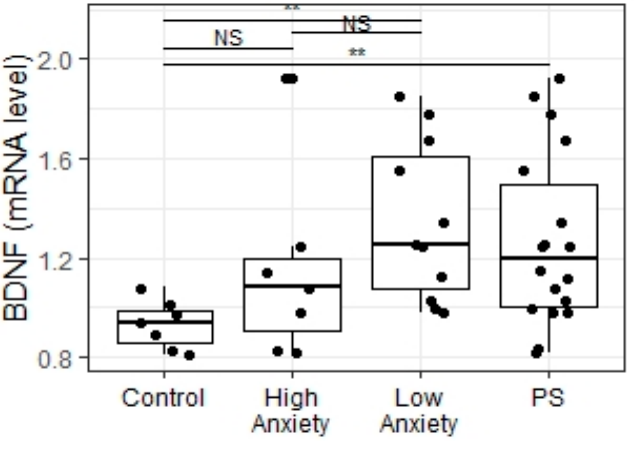
Figure 10. mRNA BDNF levels in the hippocampus of PSS rats segregated into high- and low-anxiety groups according to AI as determined by performance in the EPM. Differences in BDNF levels among groups are shown as boxplots with dots representing individual data values and medians shown by horizontal lines. The boxes include the central 50% of the data, i.e., from the 25th to the 75th percentile. The whiskers include the data contained within 1.5 times the interquartile range. NS—non-significant, p > 0.05; ** p < 0.01. p values were determined in non-parametric